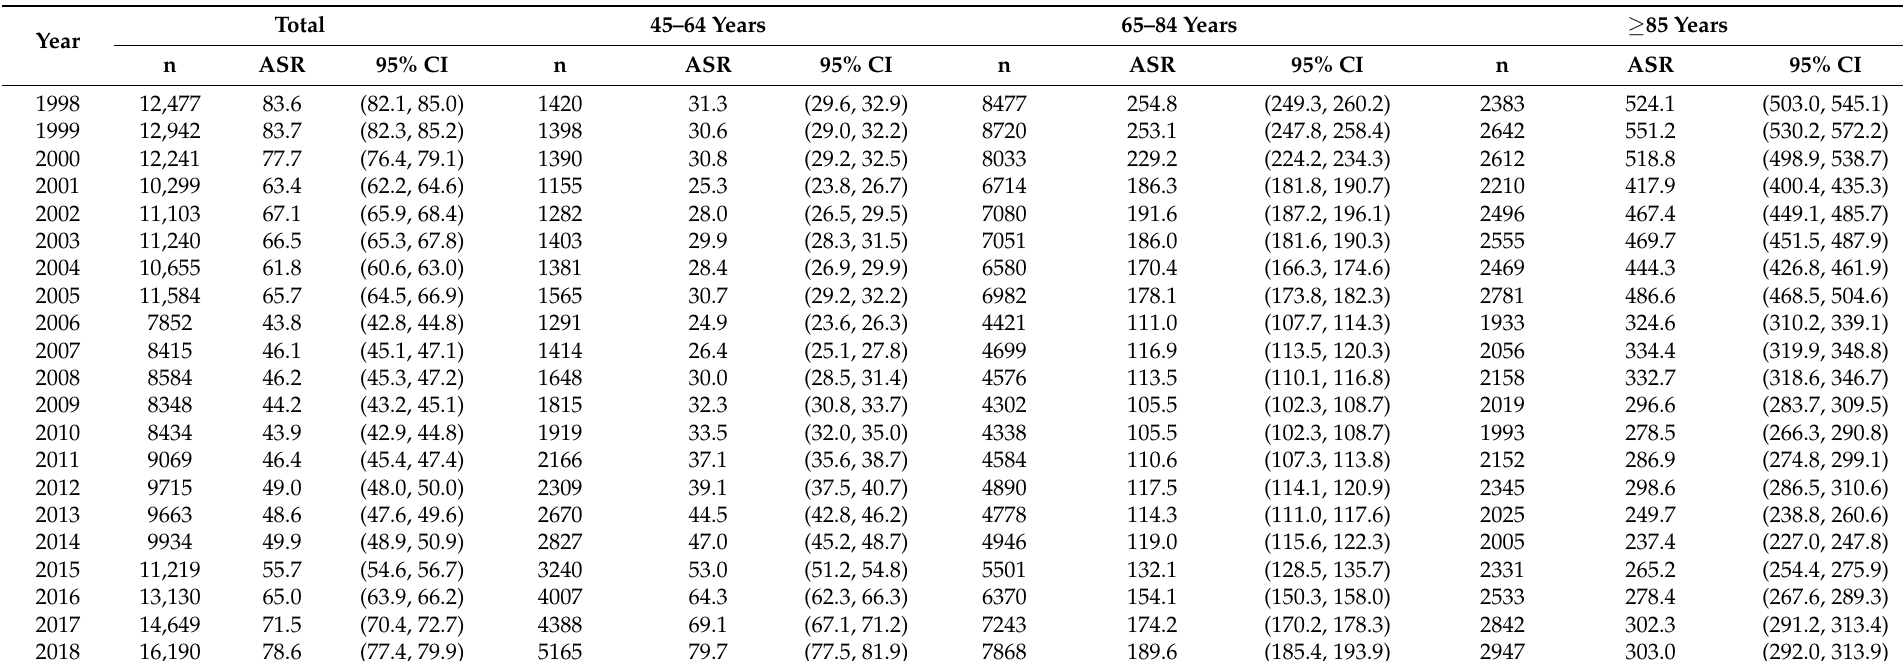
Table 2. Annual hospital admissions due to COPD and age-standardised rates (ASR) per 100,000 women/year in women, 1998 to